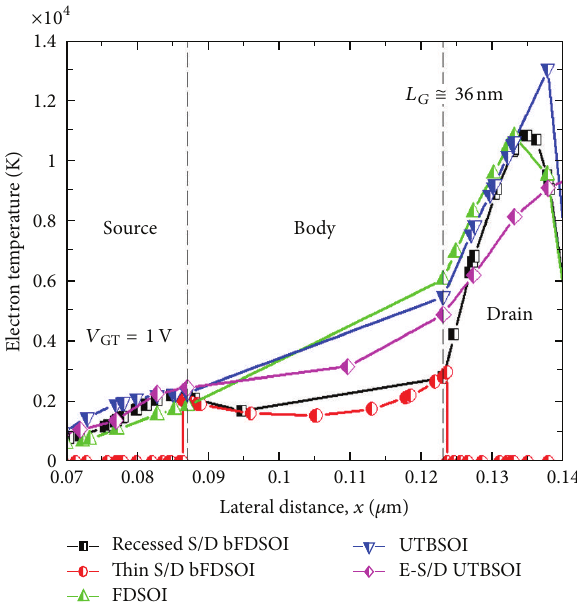
Figure 10: Simulated lateral electron temperature (K) as a function of lateral distance along the MOSFETs channel surface with gate length 𝐿 𝐺 = 36